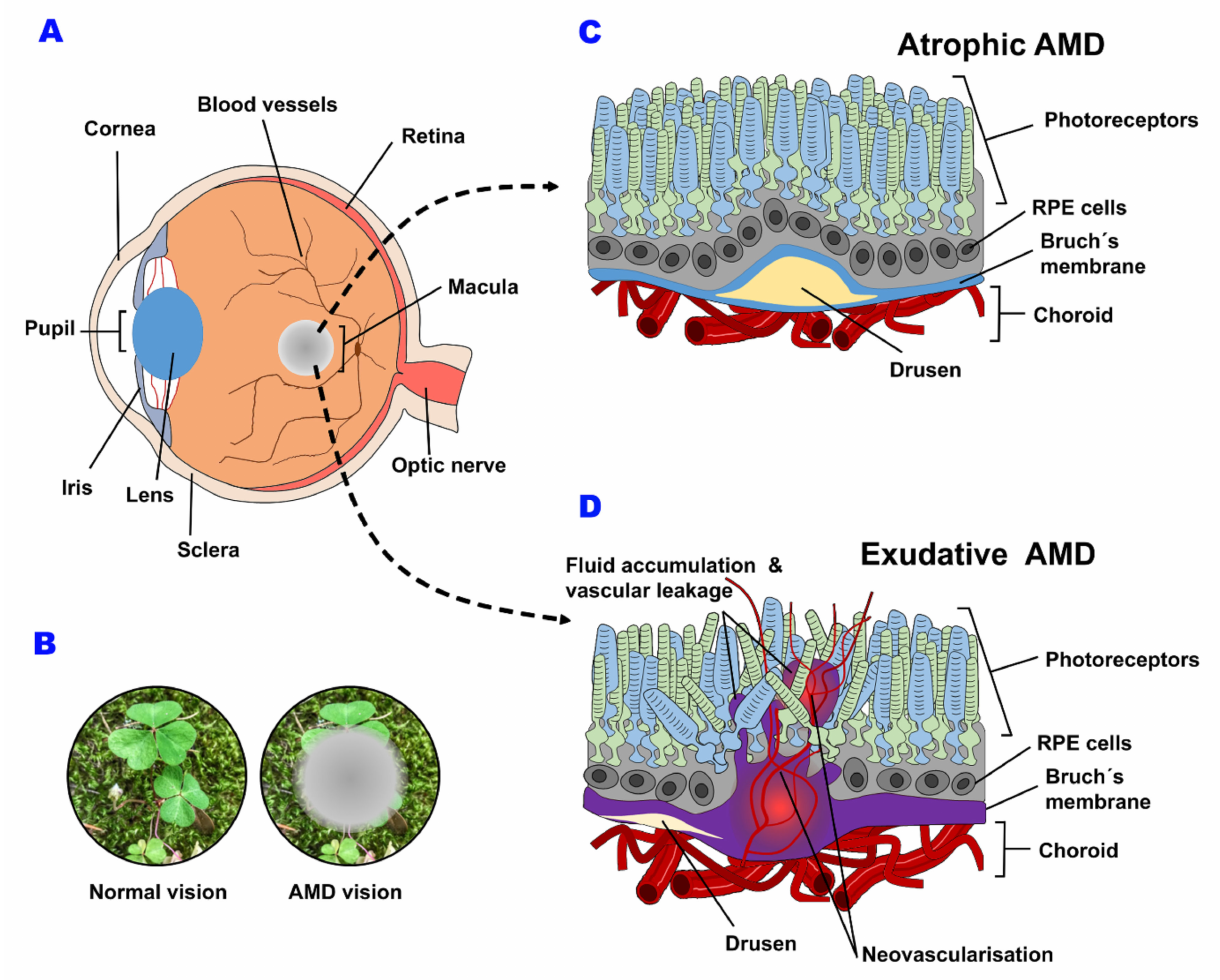
Figure 1. Schematic representation of an AMD eye ( A ) and the functional effects on vision capability ( B ) and structural retinal abnormalities associated with each subtype of AMD disease ( C , D ). Drusen accumulation, Bruch ´ s membrane alteration and RPE modifications are classical retinal changes associated with atrophic AMD ( C ), while neovascularization, fluid accumulation and vascular leakage are typical markers of exudative AMD ( D